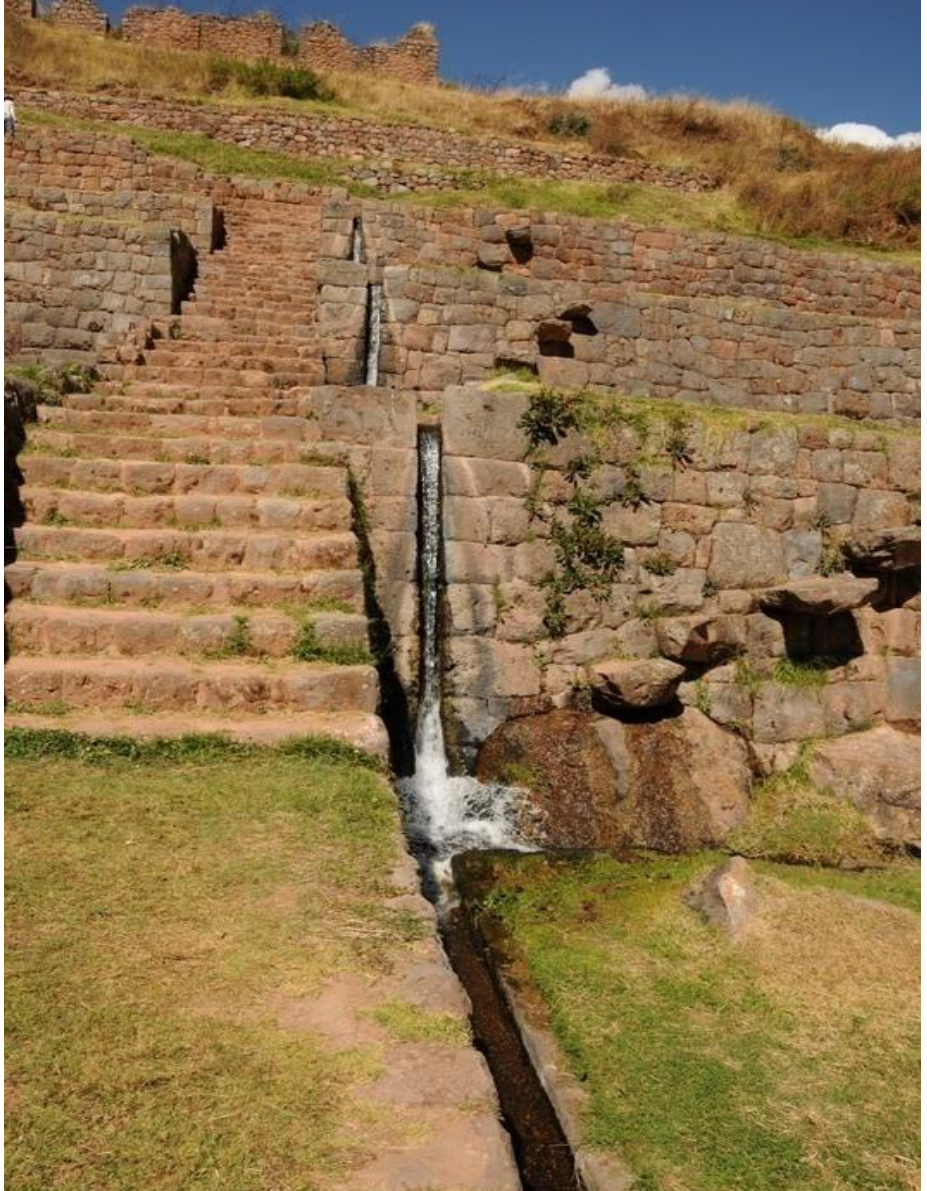
Figure 5. Successive Water drop structures collecting excess agricultural platform drainage water beyond that necessary for agricultural purposes from upper platforms and channeling water to lower site ceremonial, reservoir and occupation areas. This terrace drainage structure is to the right of the Plaza Ceremonial shown in Figure 1. (Photo by C. Ortloff) Each of the higher elevation agricultural platforms contained a base open channel collecting aquifer drainage and rainfall runoff, a portion of which was subsequently passed on to lower platforms as irrigation water or drainage water led to other site areas (Figure 5).